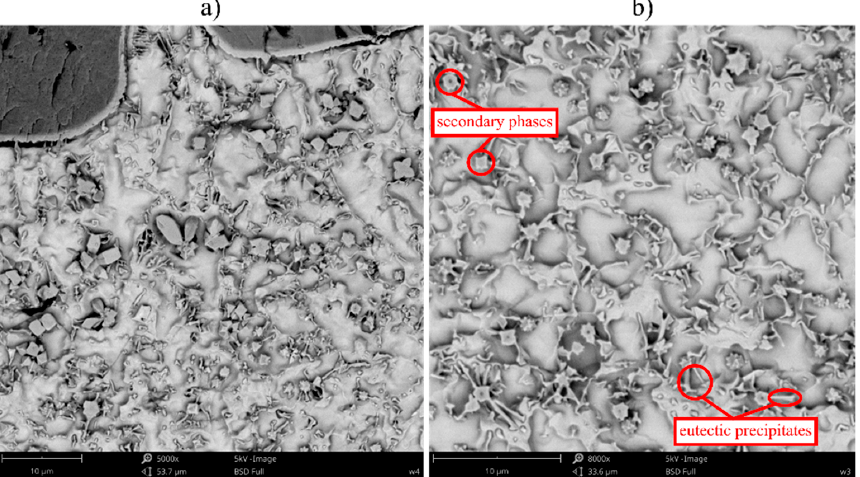
Figure 4. Microstructure of the central bead areas of the composite Inconel 625/TiC coatings: ( a ) C4, ( b ) C3, designations in accordance with Table 3.